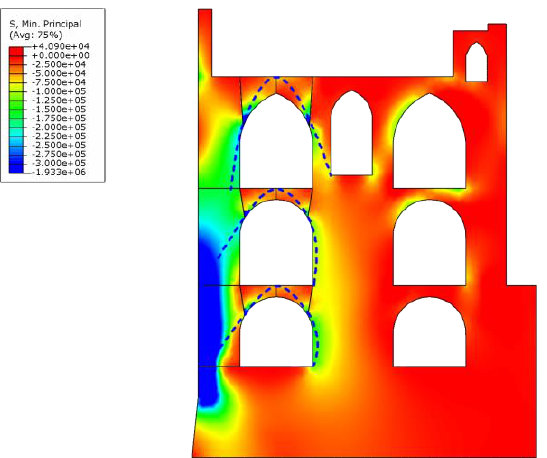
Figure 19. The results of the simplified 2D